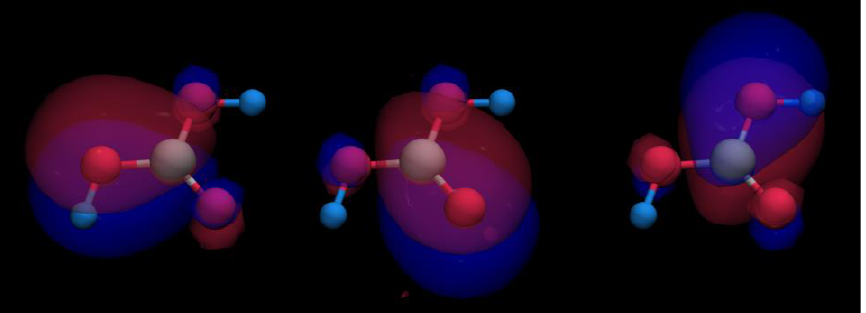
Figure A3. Molecular-dynamics simulation of carbonic acid at 2 GPa and 298 K. Shown are the behaviors of the theoretically optimized experimental structure ( left ) and the alternative theoretically predicted P 2 1 / c structure ( right ).